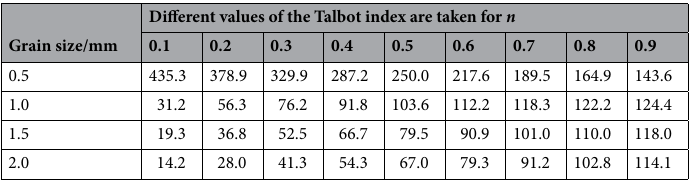
Table 1. The ratio of particle sizes in the sample.